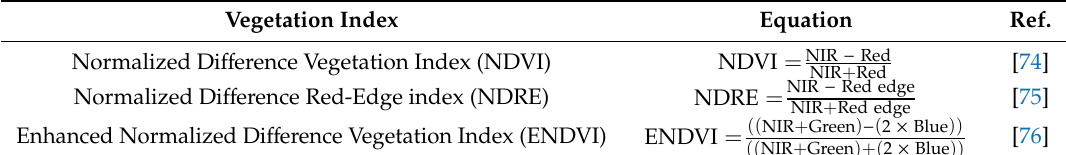
Table 6. Vegetation indices used in this study. The band names correspond with Table 1.